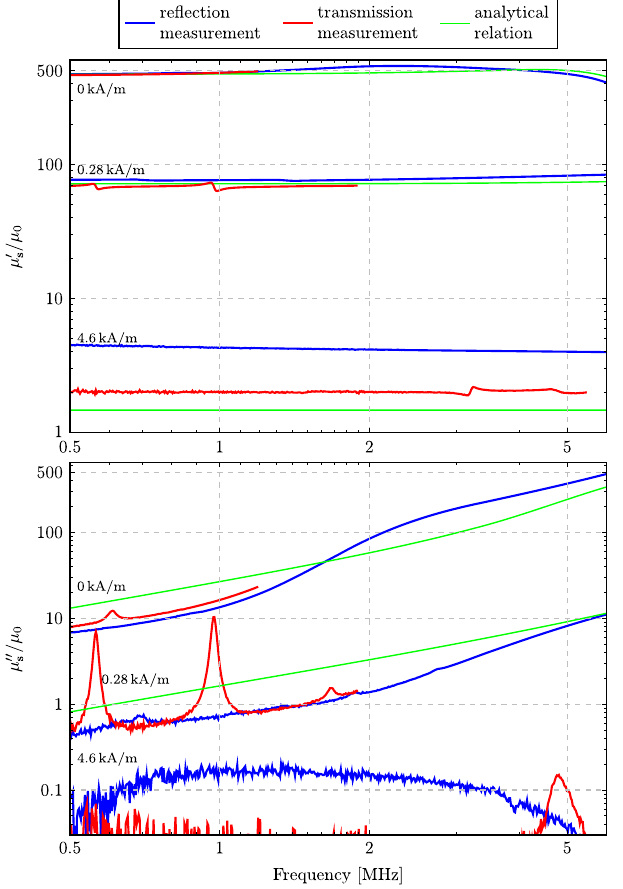
(below) of the permeability μ as obtained from the reflection and s transmission measurement analysis for three different bias mag- netic field strengths. Unlike in the analysis for the reflection setup, no corrections for the distortions, which result in sharp resonances, are applied for the transmission measurement. The empirically found analytical relation (18) is also plotted for